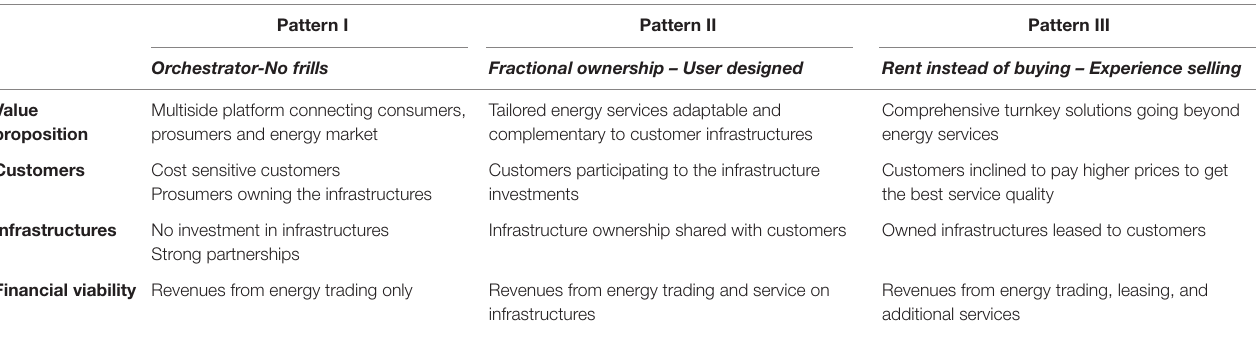
TaBle 4 | Main features of the identified general business model